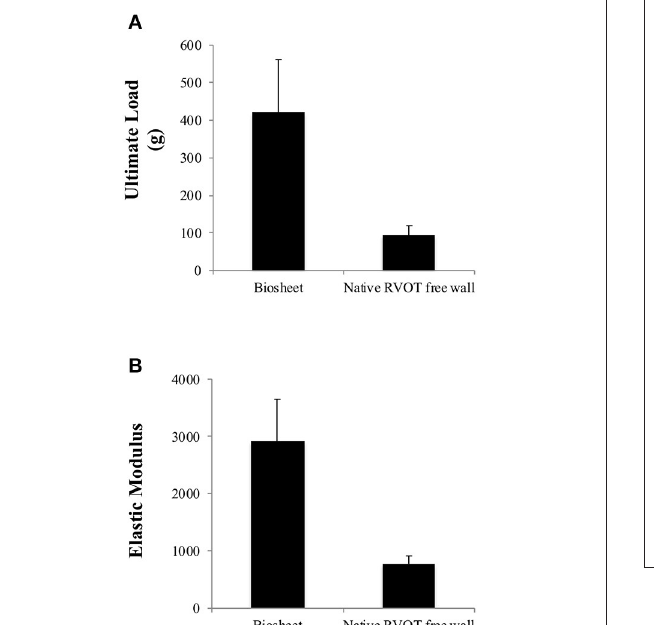
FIGURE 2 | Comparison of the ultimate load (A) and elastic moduli (B) of the biosheets and native RVOT-free wall. The strength and elastic moduli of the biosheets were significantly higher than those of the native RVOT-free walls.